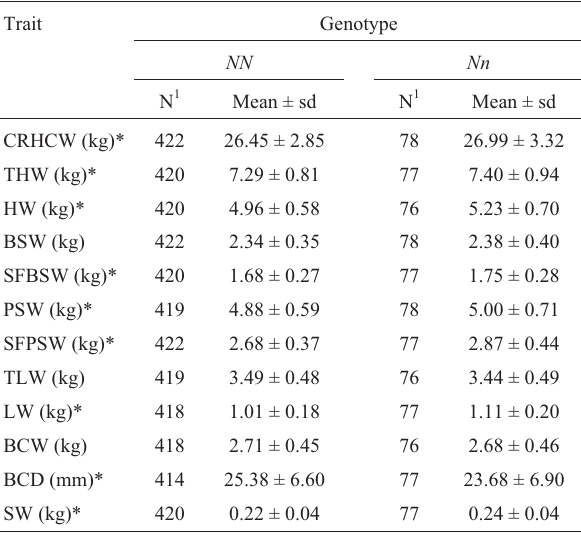
Table 2 - Cut yields (means and standard deviations) obtained for each PSS genotype ( NN and Nn ).